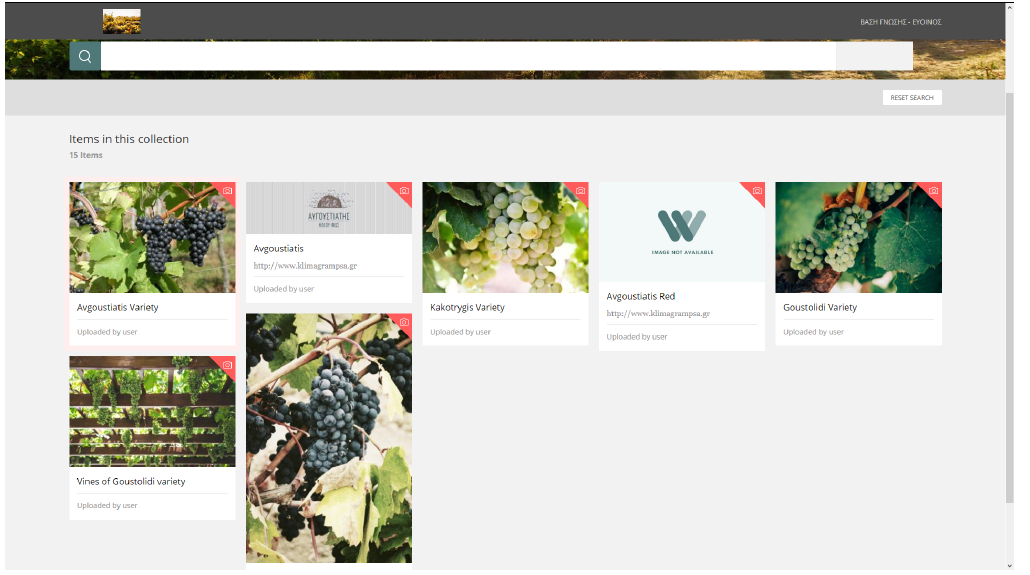
Figure 11. Grampsas knowledge base item